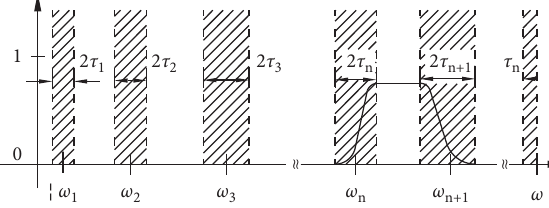
Figure 10: Schematic diagram of interval